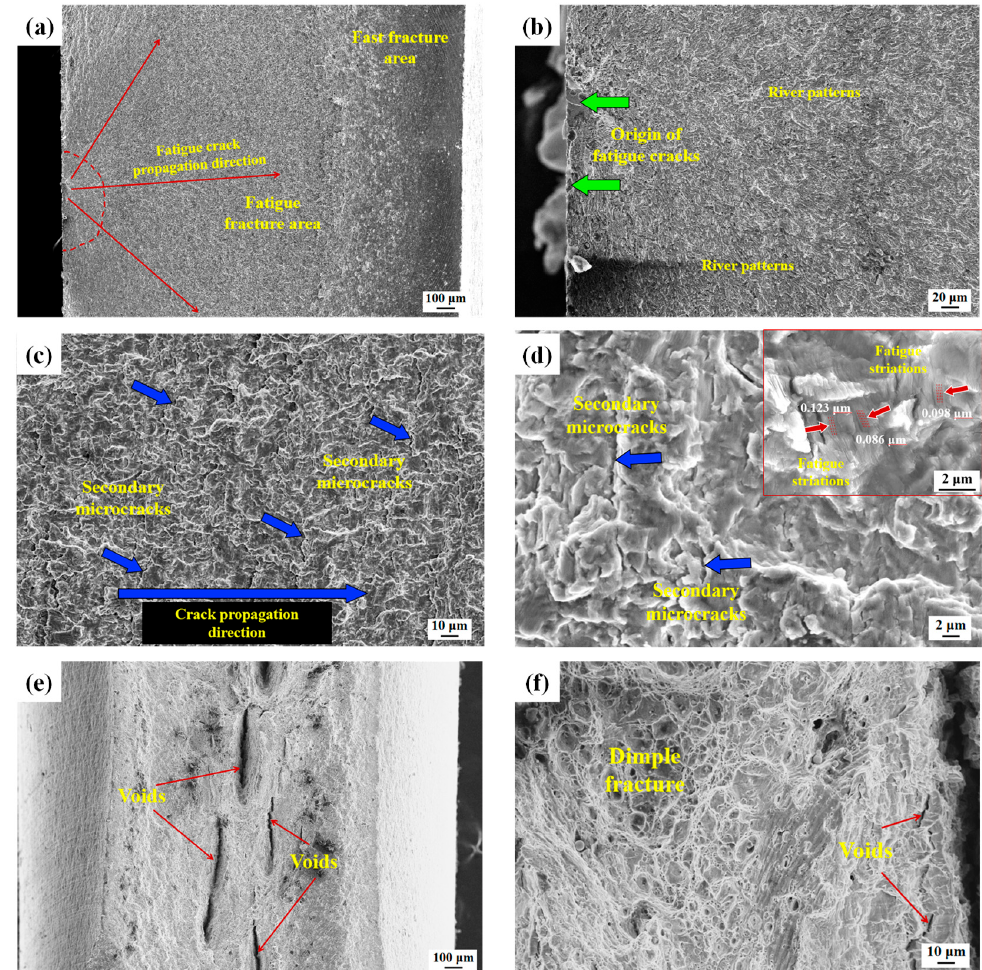
Figure 10. Fatigue fracture morphology of Beam-2 Steel, σ a = 685 MPa, N f = 2.7 × 10 5 : ( a , b ) fatigue crack initiation area, ( c , d ) fatigue crack stable propagation area, ( e , f ) fatigue crack instability propagation area.